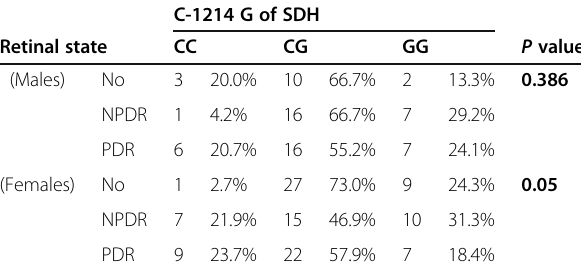
Table 6 Genotype frequency of C-1214G polymorphism of SDH gene in relation to severity (NPDR and PDR) of retinopathy in both genders C-1214 G of SDH